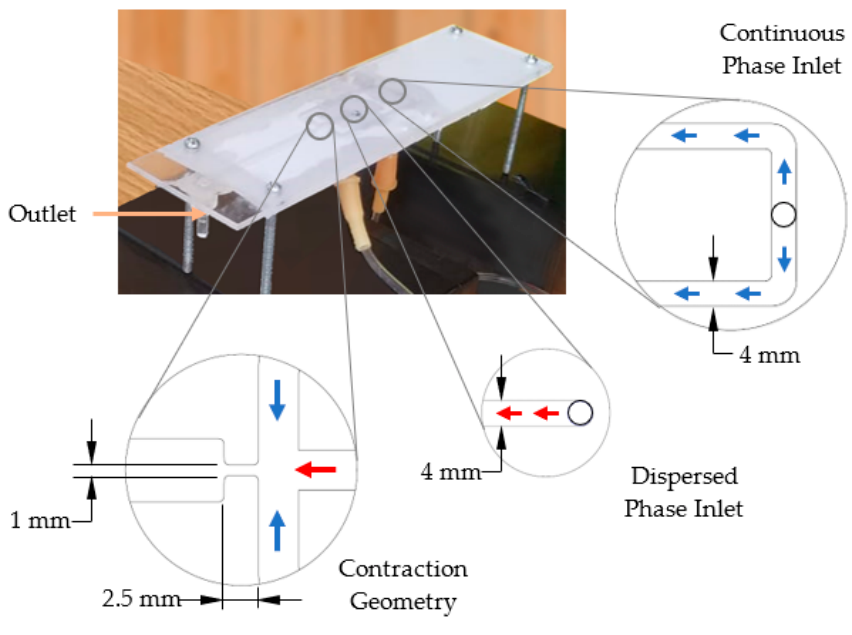
Figure 3. Droplet generator.